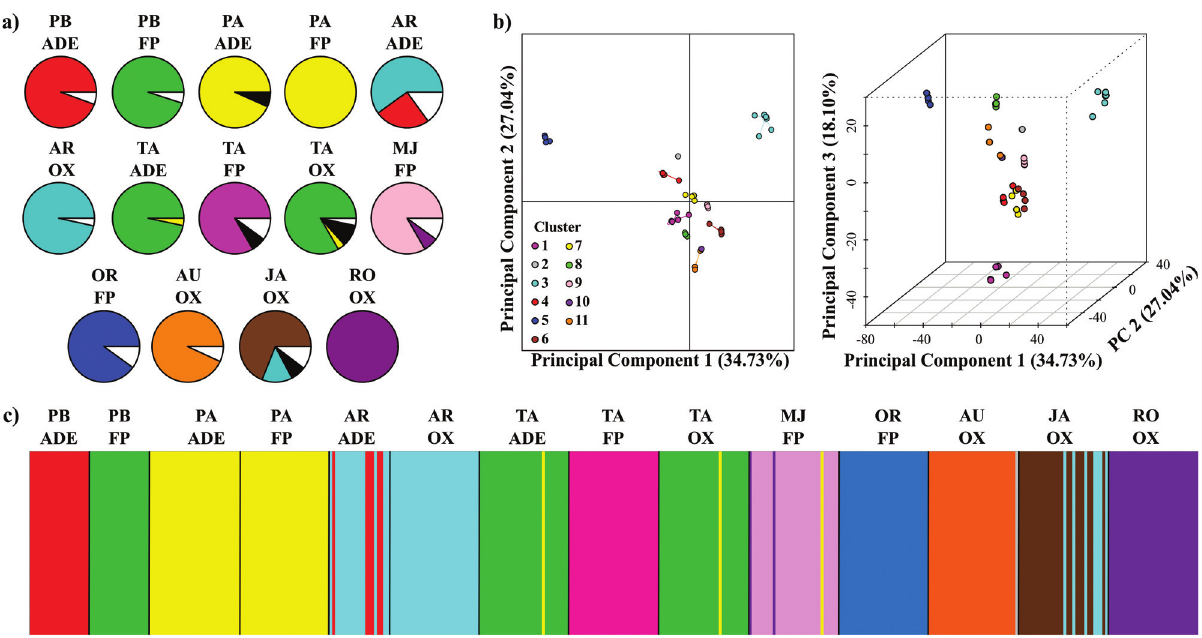
Figure2 -ComparisonofgeneticdiversityandstructureofbittermaniocvarietiescultivatedinthreesoiltypesinManicoré,Amazonas,Brazil.a)Propor- tions of multilocus genotypes (MLGs), where different colors represent distinct MLGs. Black sections represent individuals that shared MLGs different from the dominant MLGs of their varieties (those in different varieties correspond to distinct MLGs). White sections represent unique MLGs for the whole set of varieties (and each section may be composed of more than one MLG). b) 2-D and 3-D results of DAPC analysis at K -means = 11 groups. c) Structure-like barplot based on individuals’ membership probabilities to clusters generated in DAPC. Each individual is represented as a vertical line par- titioned into colored segments, the length of which is the probability of the individual belonging to each K -means cluster. Figures were colored according to the preponderant MLG found in each variety. The identification of varieties follows the acronyms in Table